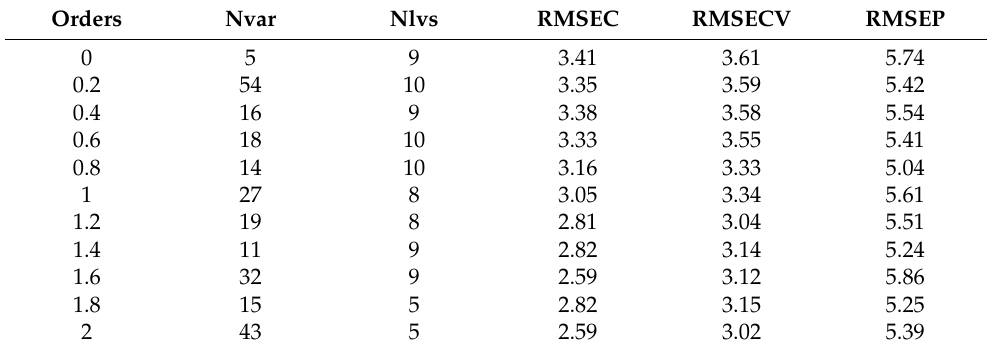
Table 3. Results of VCPA-GA hybrid strategy based on the hyperspectral datasets (0–2 order).